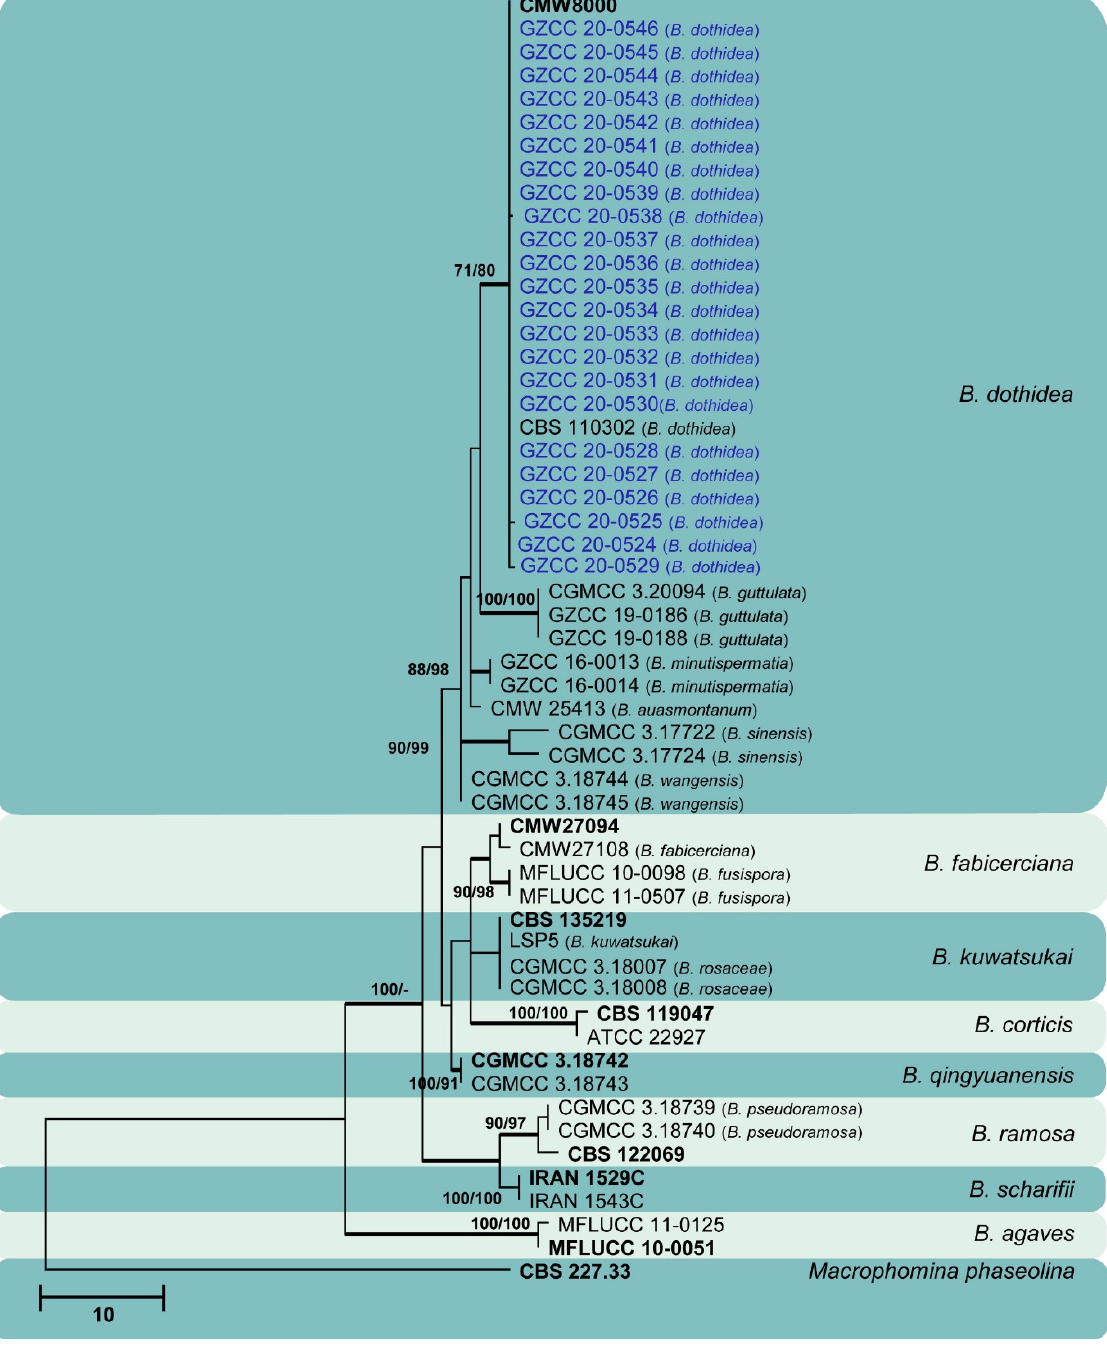
Figure 10. Maximum likelihood tree based on analysis of combined ITS and tef sequences of Botryosphaeria . Bootstrap support values of ML, MP > 75% are shown near the nodes, and branches in bold indicate BI probabilities >0.95. Isolates obtained in this study are in blue for known species. Ex-type strains are in bold. The tree is rooted to Macrophomina phaseolina (CBS 227.33).